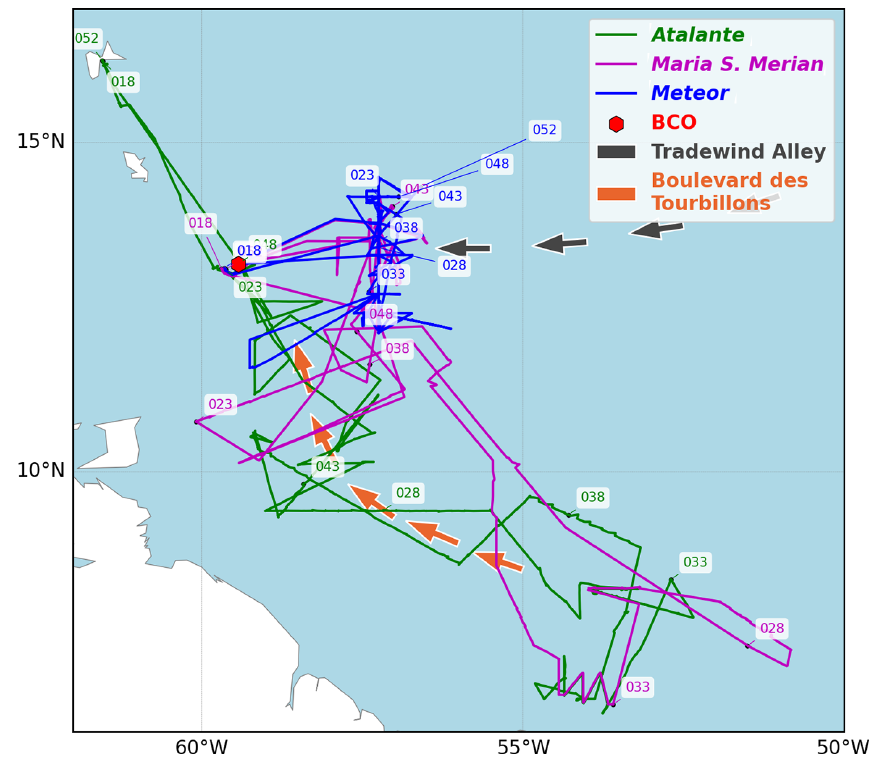
Figure 2. Ships trajectory from start to end of the EUREC 4 A campaign. BCO denotes the Barbados Cloud Observatory. Labels indicate vessel passage dates (day of year in 2020), and the arrows schematic represents Trade-wind Alley (black arrows) and the Boulevard des Tourbillons (orange arrows).